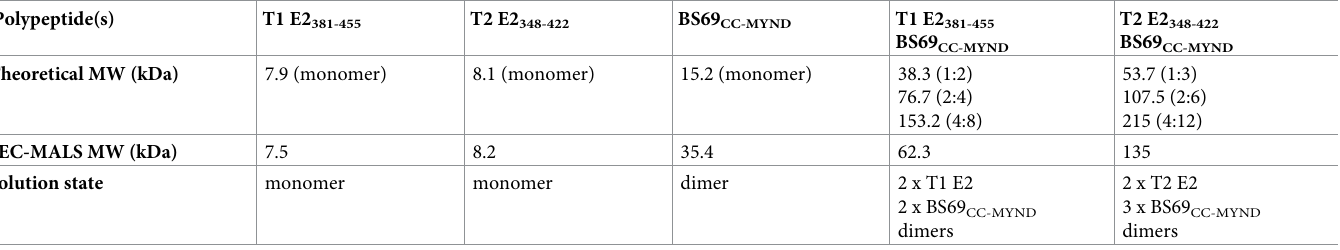
Table 1. Size exclusion chromatography and multi-angle light scattering (SEC-MALS) determination of the molecular weight of individual type 1 and type 2 EBNA2 polypeptides, BS69 CC-MYND and EBNA2-BS69 complexes.